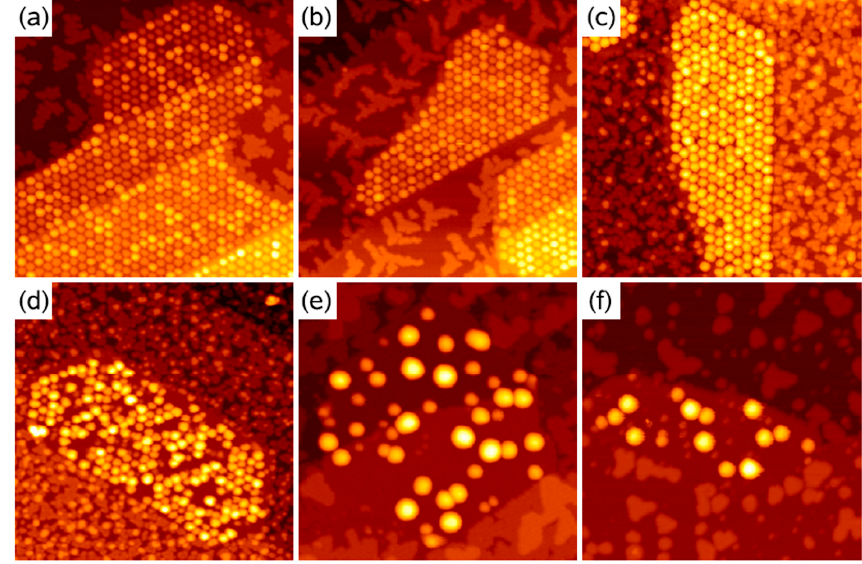
Figure 12. Scanning Tunneling Microscopy images (70 nm × 70 nm) of graphene flakes on Ir(111) after deposition, maintaining the substrate at 300 K, of: ( a ) 0.20 ML Ir; ( b ) 0.25 ML Pt; ( c ) 0.44 ML W; ( d ) 0.53 ML Re; ( e ) 0.77 ML Fe; ( f ) 0.25 ML Au. Reproduced from Reference [64] with permission from IOPscience.